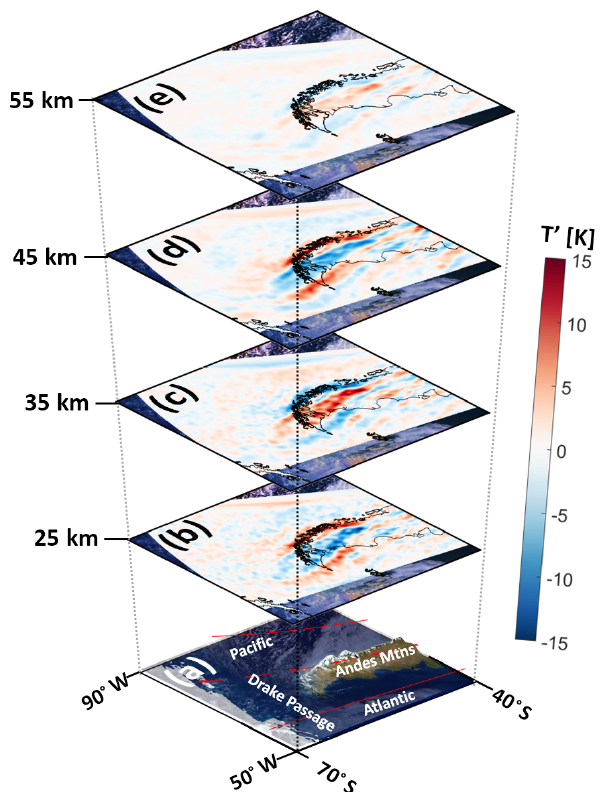
Figure 2. (a) Map of the region covered by AIRS granules 56–58 on 6 May 2008. Red solid lines indicate the AIRS scan track out- line, and red arrows indicate the direction of satellite travel. (b–e) T (cid:48) measured by AIRS at four height levels above this region. The expo- nential increase in wave amplitude with altitude has been removed in (b–e) for consistency with Fig.